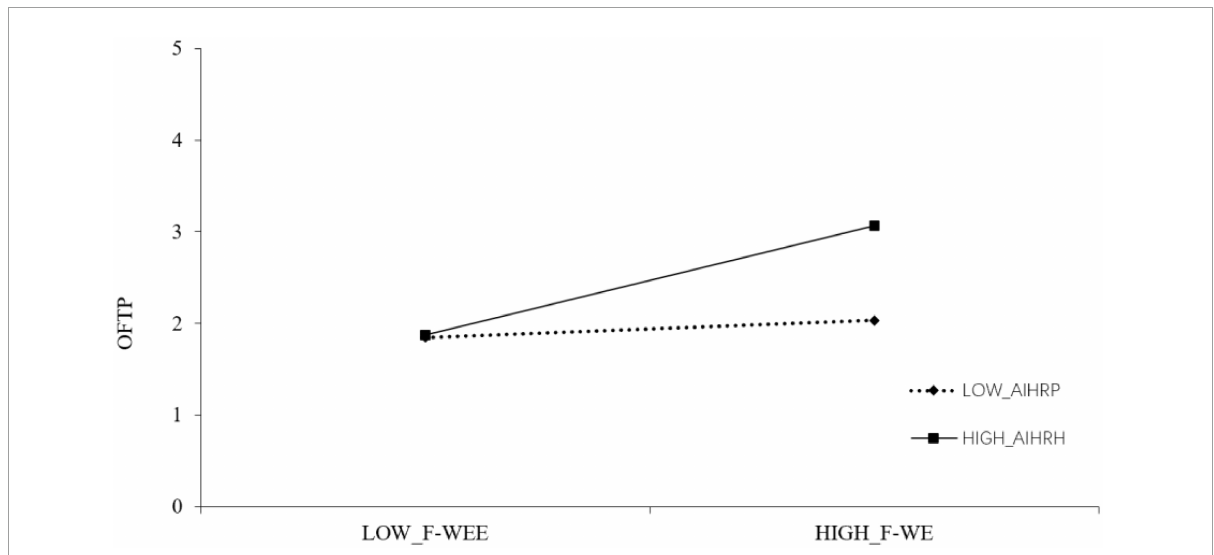
FIGURE3 The moderating role of AIHRP between F-WE and OFTP. F-WE, family → work enrichment; OFTP, occupational future time perspective; AIHRP, age-inclusive HR